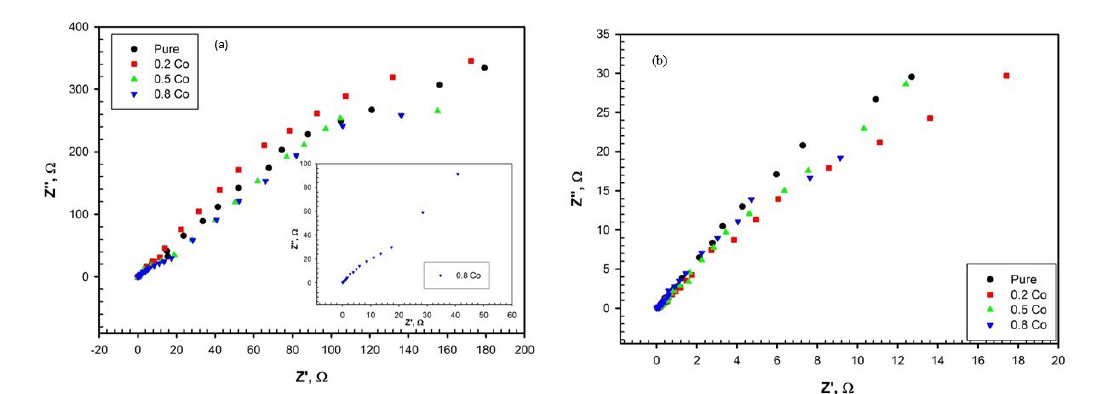
Figure 13. Nyquist plot at potential -1.3 V for Zinc Ferrite and Co-Zinc Ferrite prepared by (a) solid state at 800 o C (b) microwave at 1000 o C. (Inset: Enlargement of the Nyquist plots in high frequency